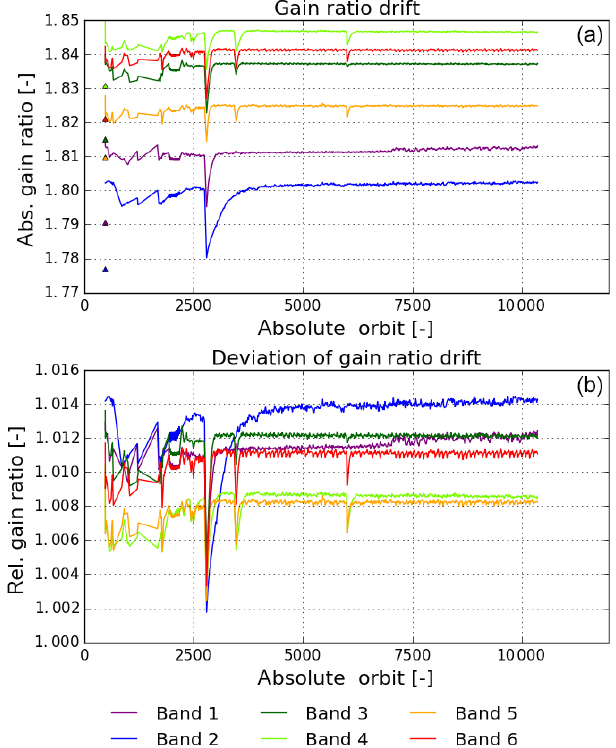
Figure 2. Gain drift of the UVN CCD detector output nodes. Panel (a) shows the ratio of the high- and low-CCD-gain setting over time, and panel (b) shows this ratio over time with respect to the on-ground ratio. The different colours represent the different detector bands (see legend). The triangles in the top panel show the gain ratio as derived from on-ground